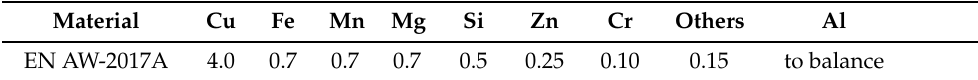
Table 1. Chemical composition of EN AW-2017A aluminum alloy (% weight).